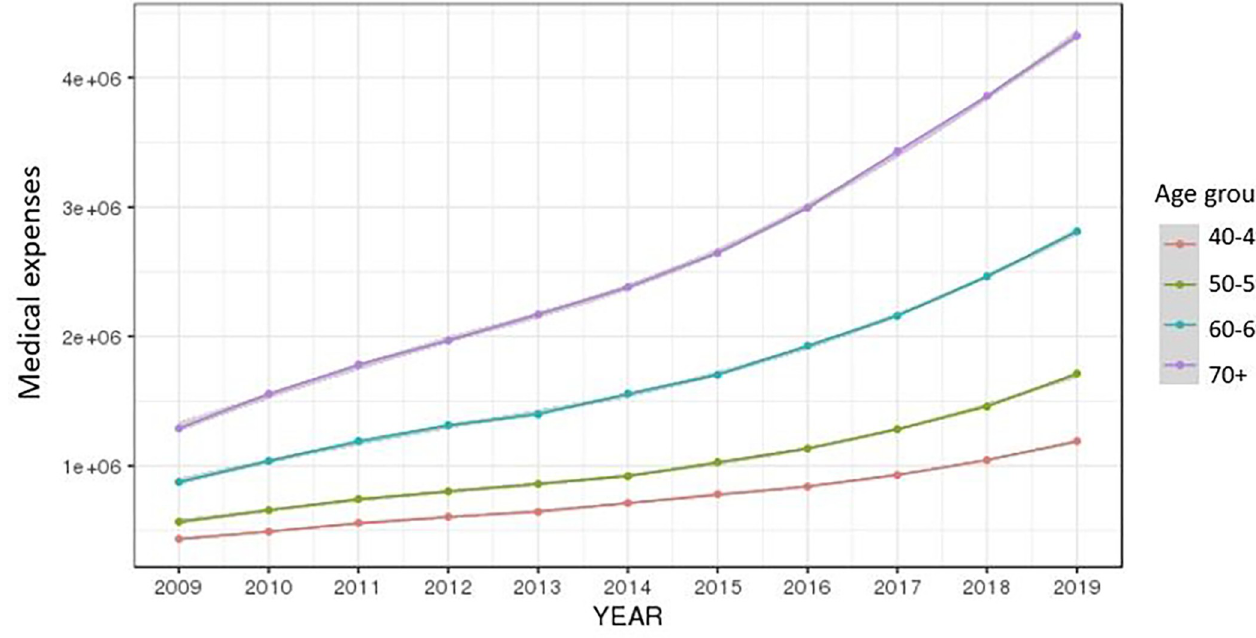
Fig 3. Ten-year trend of medical expenses by age group.